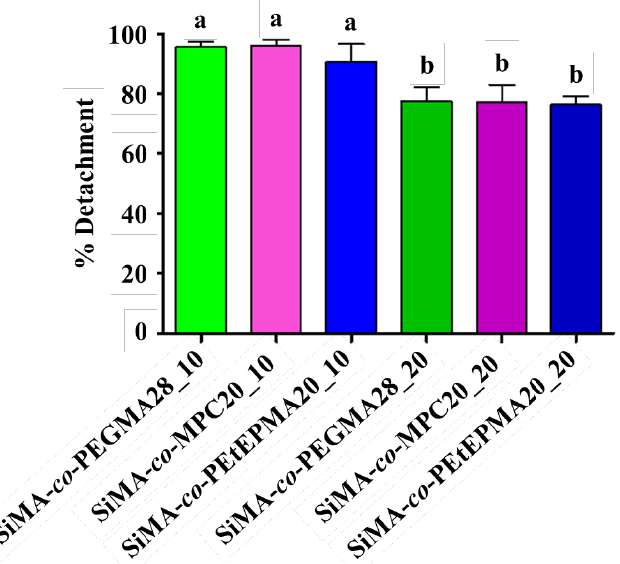
Figure 8. Percentage of detachment of N. salinicola cells from different surface samples, after 5 Pa shear stress exposure (five minutes). An ANOVA analysis (n = 3) followed by a Tukey post-hoc test were performed for multiple comparisons. Not-shared letters indicate statistically significant differences, p ≤ 0.05. Detachment percentage for PDMS was 93.50 ± 5.97% (mean ± standard deviation).